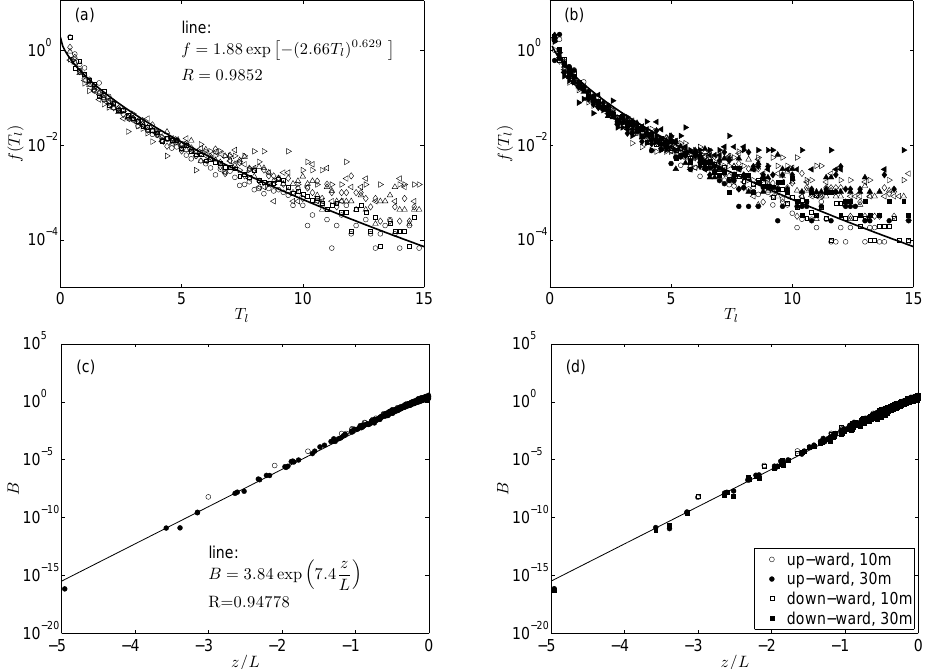
Fig. 11. (a) PDFs of the dimensionless durations T l of extreme vertical velocity fluctuations. Line is the fitted stretched exponential dis- tribution. (b) PDFs of dimensionless durations of down-ward (filled symbols) and up-ward (open symbols) extreme fluctuations. Line is the same function as that in (a). Different symbols in (a) and (b) represent different stability ranges which are the same as those in Figure 3a. (c) Variations of dimensionless mean durations as a function of z/L . The dimensionless duration B is defined by (27). Filled symbols are measured at 30 m and open ones are measured at 10 m. Line is the fitted exponential function. (d) Variations of B for the down-ward (squares) and up-ward (circles) extreme fluctuations separately. Line is the same function as that in (c).